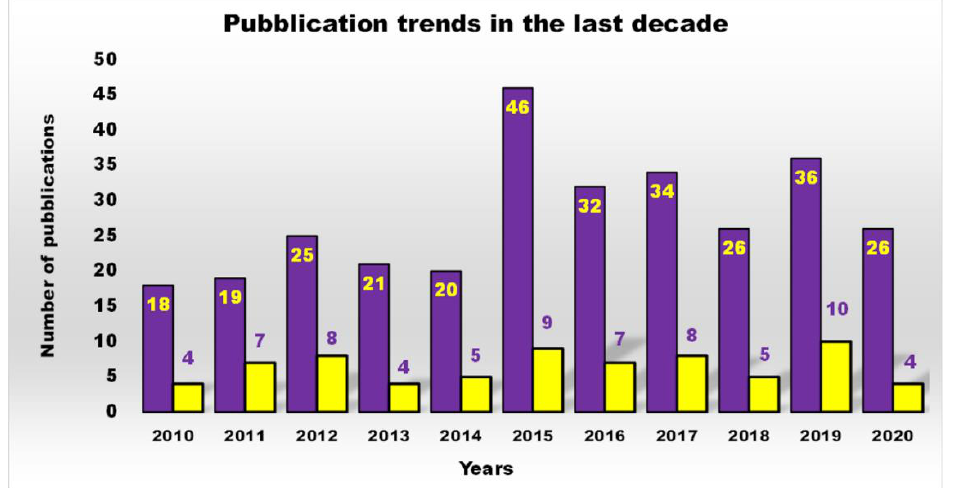
Figure 2. Number of publications, as a function of time, obtained by typing the key phrase “antimicrobial dendrimers” in Scopus (purple bars) and that obtained by typing “cationic antibacterial dendrimers” (yellow bars), topic of the review.